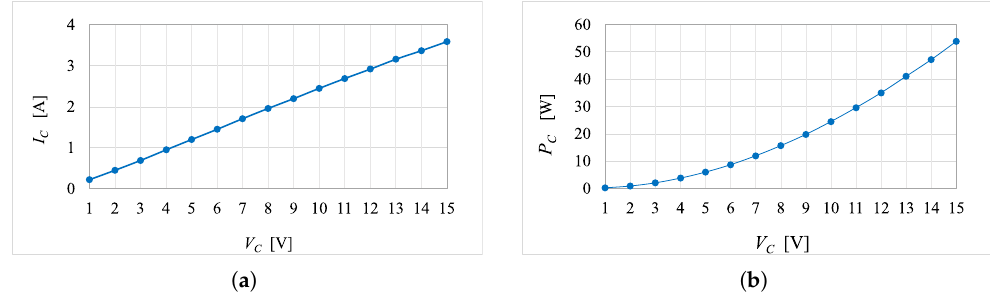
Figure 8. Experimental data of the thermoelectric cooler TEC1-12706 operating in the PAWG. ( a ) Cur- rent vs. voltage plot; ( b ) Power vs. voltage plot. Table 1. Calculated value of SPD EC and estimated value of A CC